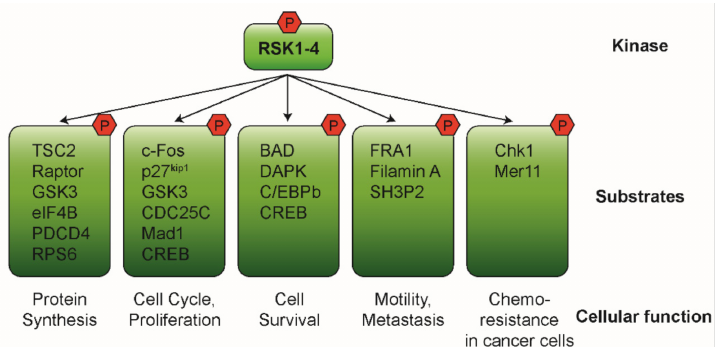
Figure 4. Molecular targets and cellular function of RSK isoforms. RSKs control diverse cellular processes by regulating extensive downstream